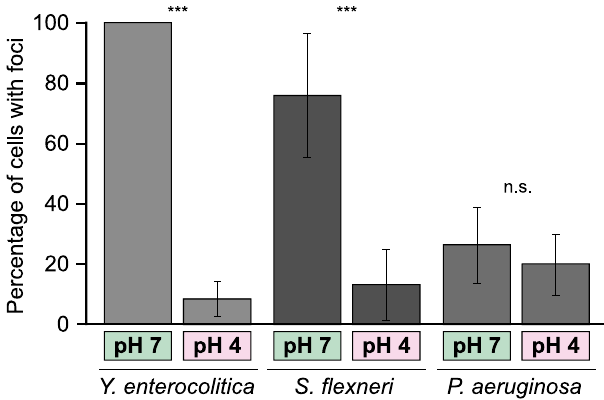
Fig. 6 The effect of external pH on the assembly of cytosolic T3SS components is species-speci fi c. Percentage of bacteria with fl uorescent foci at the indicated external pH for Yersinia enterocolitica EGFP- Ye SctQ, Shigella fl exneri GFP- Sf SctN, and Pseudomonas aeruginosa EGFP- Pa SctQ, respectively. n = 1134/1270, 530/691, 1078/926 bacteria from 20, 22, 25 fi elds of view (pH 7/pH 4 from left to right) from three independent experiments per condition. Bars denote mean values, error bars denote standard deviation between fi elds of view. n.s., difference not statistically signi fi cant; *** p < 0.001 in a two-tailed homoscedastic t -test ( p ~ 2 × 10 − 44 , 6 × 10 − 16 , 0.053,